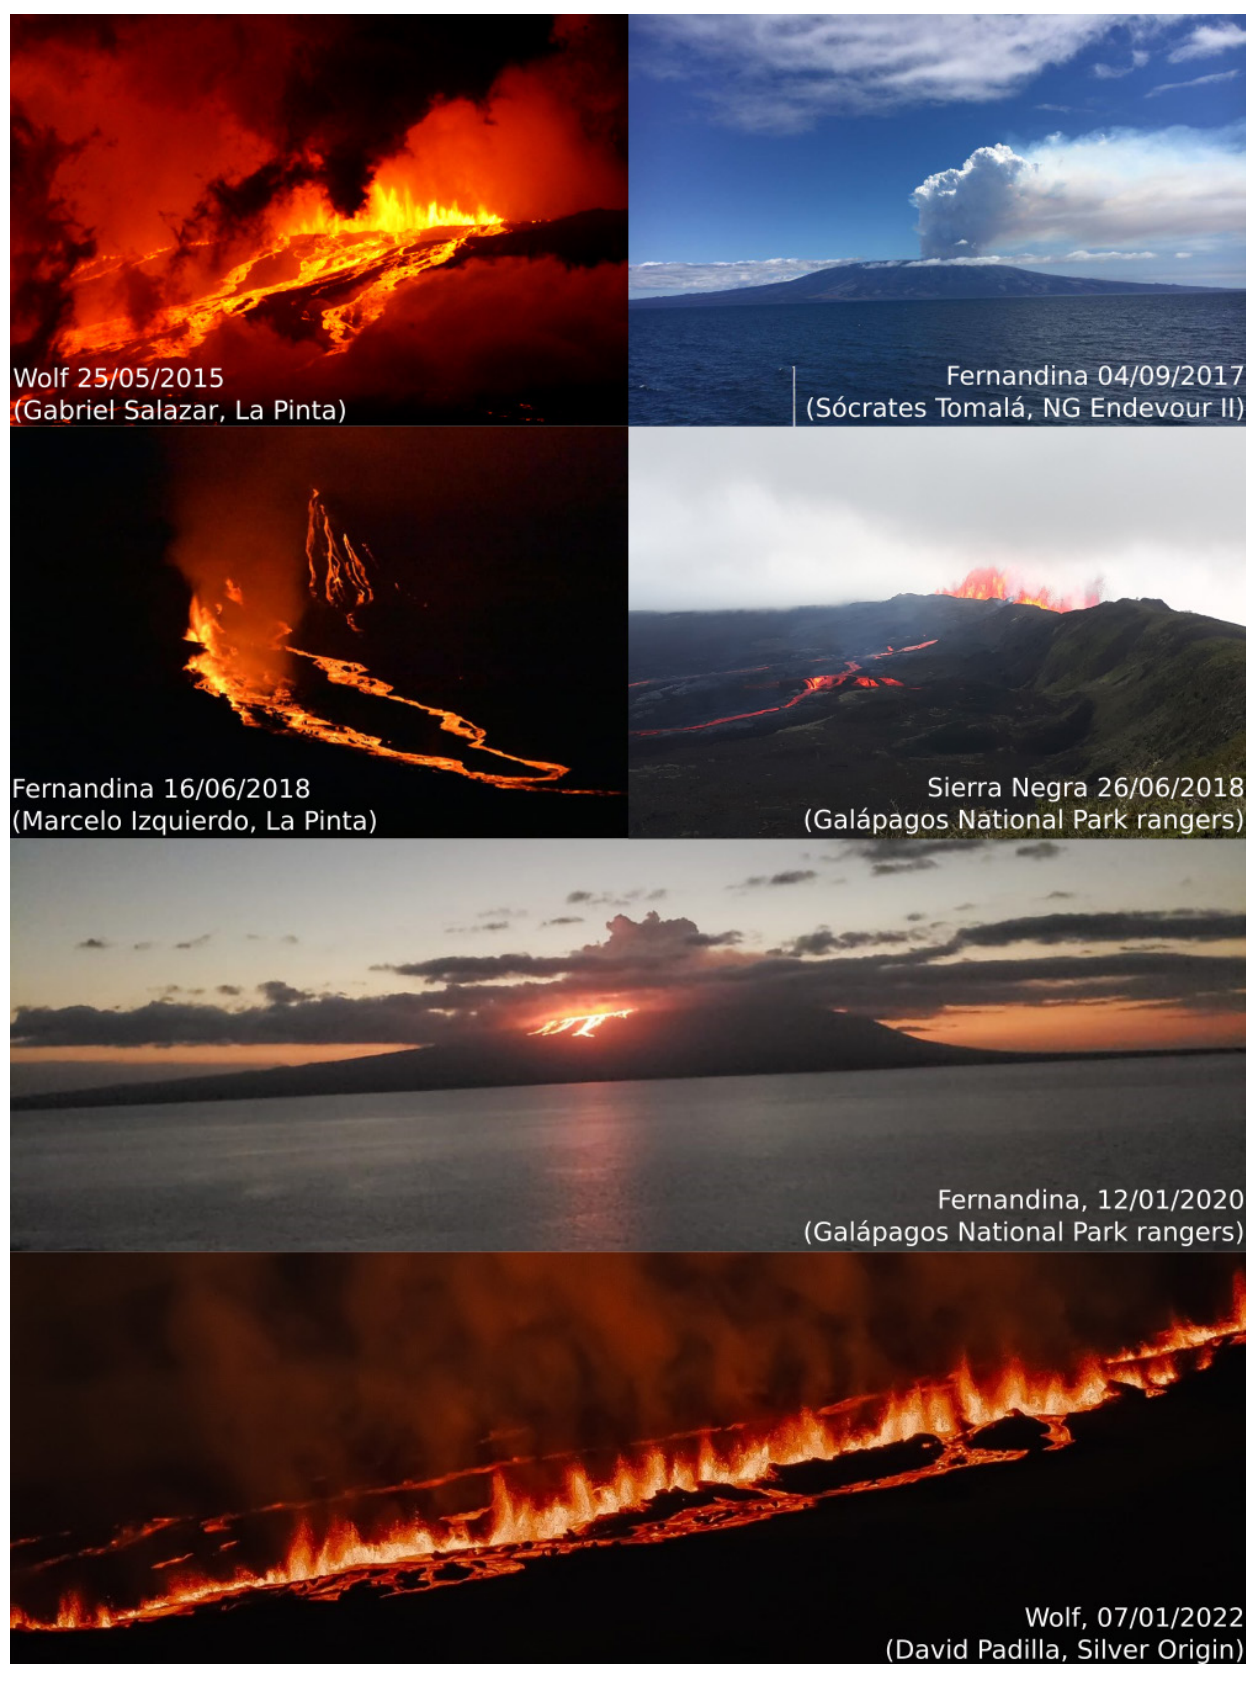
Figure 4: [Caption on next